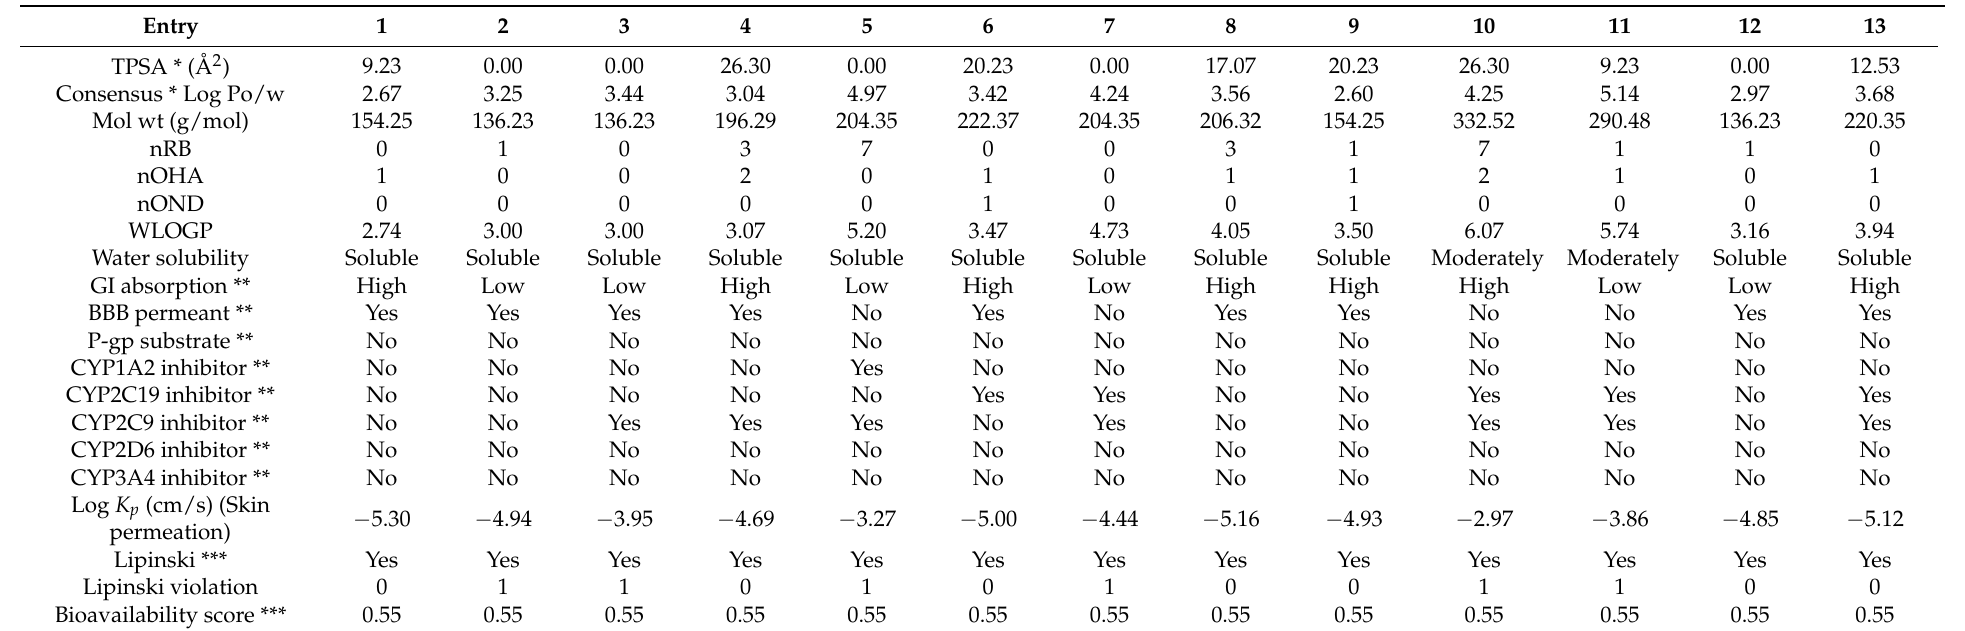
Table 5. In silico ADMET analysis of major constituents of VAO, VNO, and VTO.